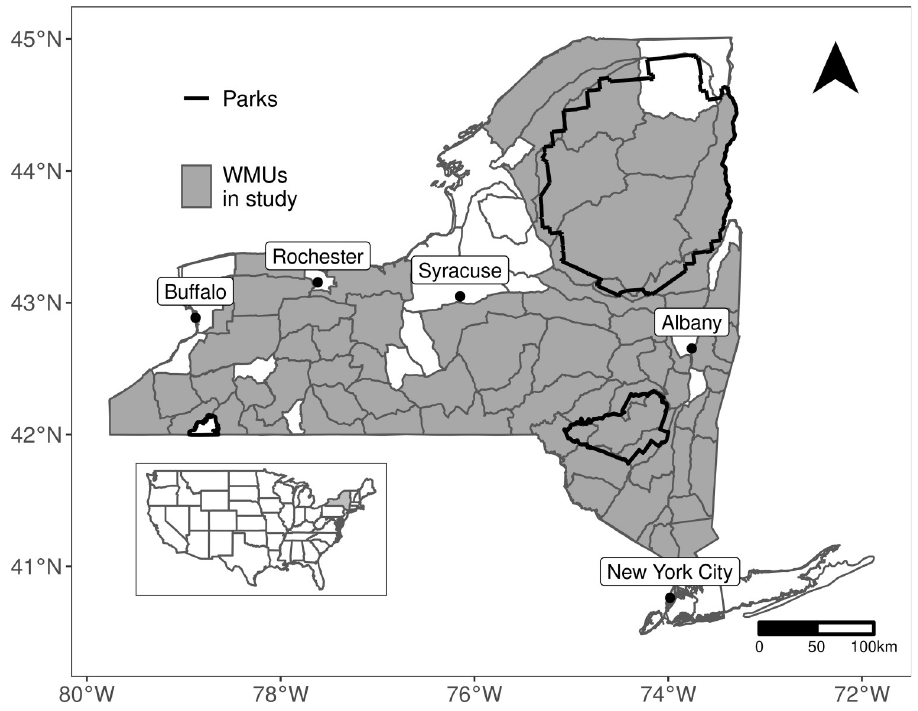
Fig 1. Locations of 68 Wildlife Management Units from which we obtained human-black bear conflict data, New York, USA. Major park boundaries are in black.